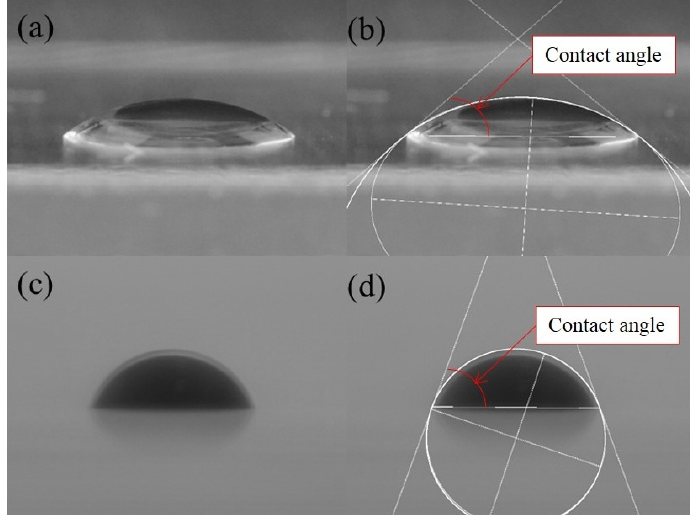
Figure 3. Contact angle on a silica surface ( a , b ) in air and ( c , d ) in decane as determined using high ‐ resolution time ‐ lapse photography and Image J.